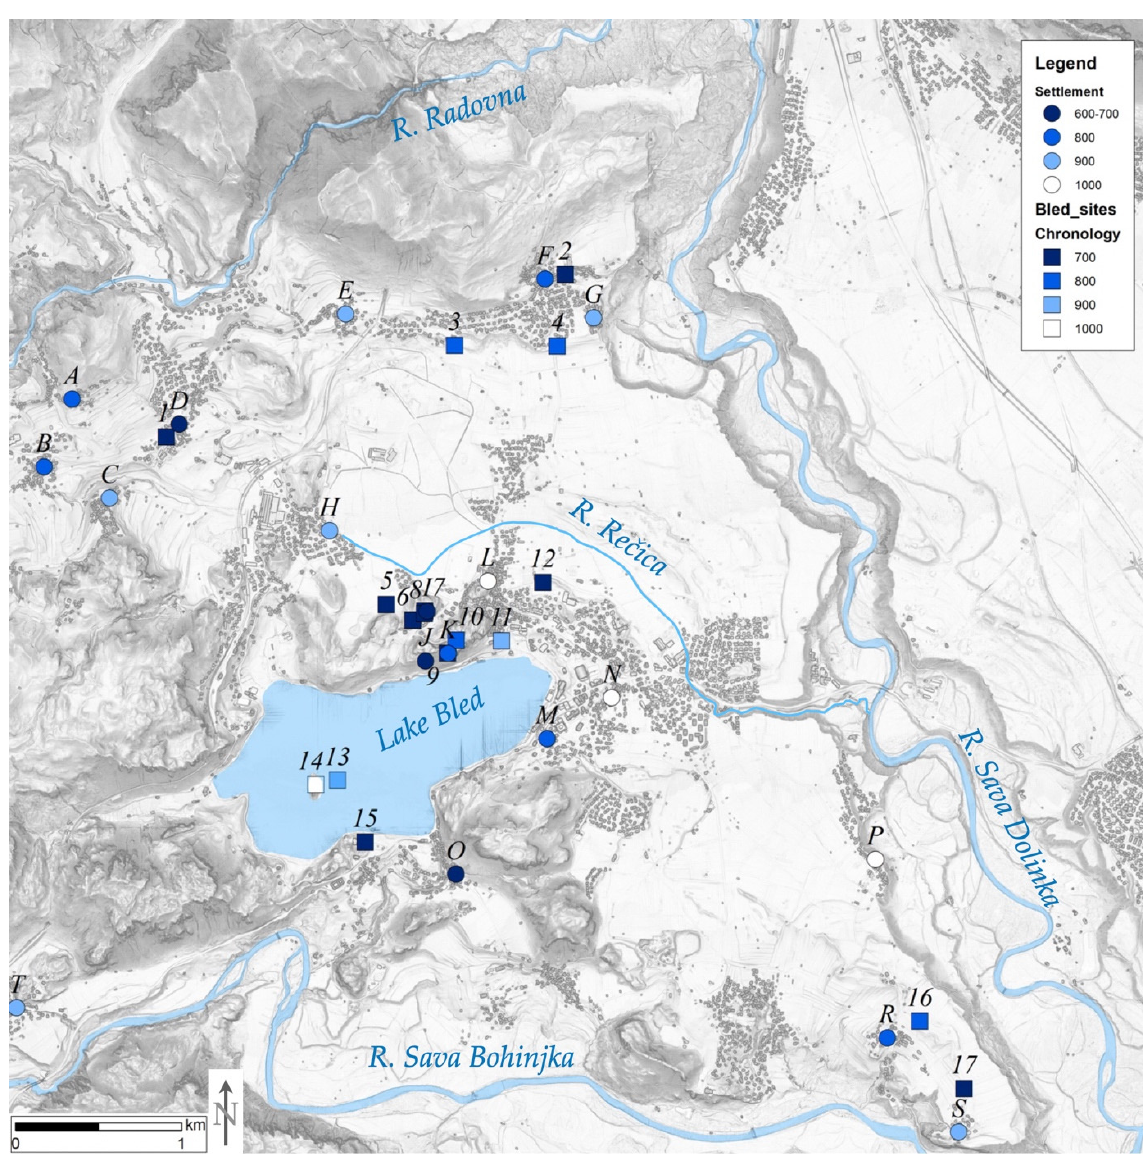
Figure 3. Bled microregion (decimal longitude and latitude coordinates of the map centre: 14.1139; 46.3752), early medieval sites (numbers refer to Table 1) and settlements (letters refer to Table 2) in the Bled microregion. The colours refer to the century of foundation (labelled as year AD in the legend).